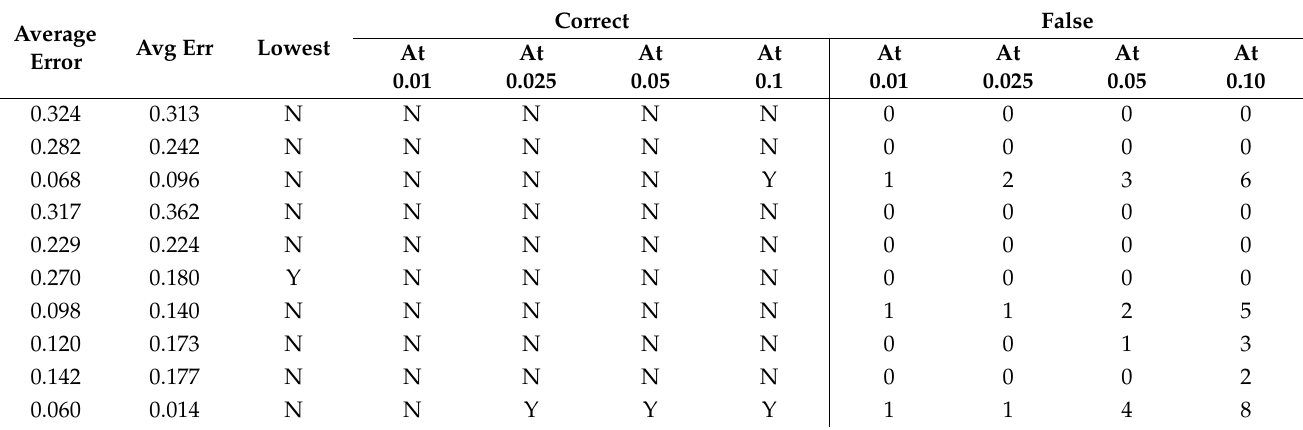
Table A109. Set 2, trials 11–20 data (average actual PR values).